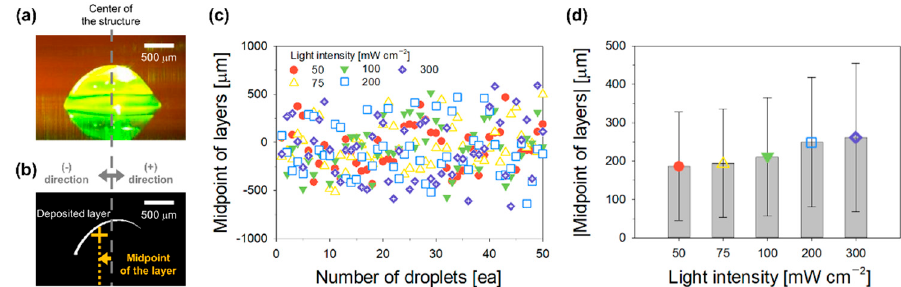
Figure 3. Analysis of the shape and position of deposited single layers. ( a ) Photograph of a deposited single layer acquired after the droplet–structure collision; ( b ) the morphology of the formed single layer; ( c ) the distribution; ( d ) average, and standard deviation of the midpoints of the deposited single layers as a function of light intensity.